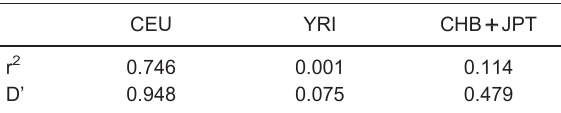
Table 4. Linkage disequilibrium (as r 2 and D’) between rs12255372 and rs7903146 of the TCF7L2 gene in multiple